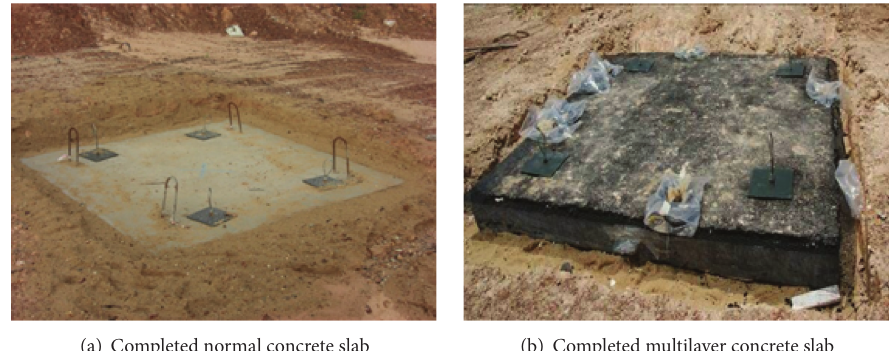
Figure 6: Normal concrete and multilayer slabs before blast tests.